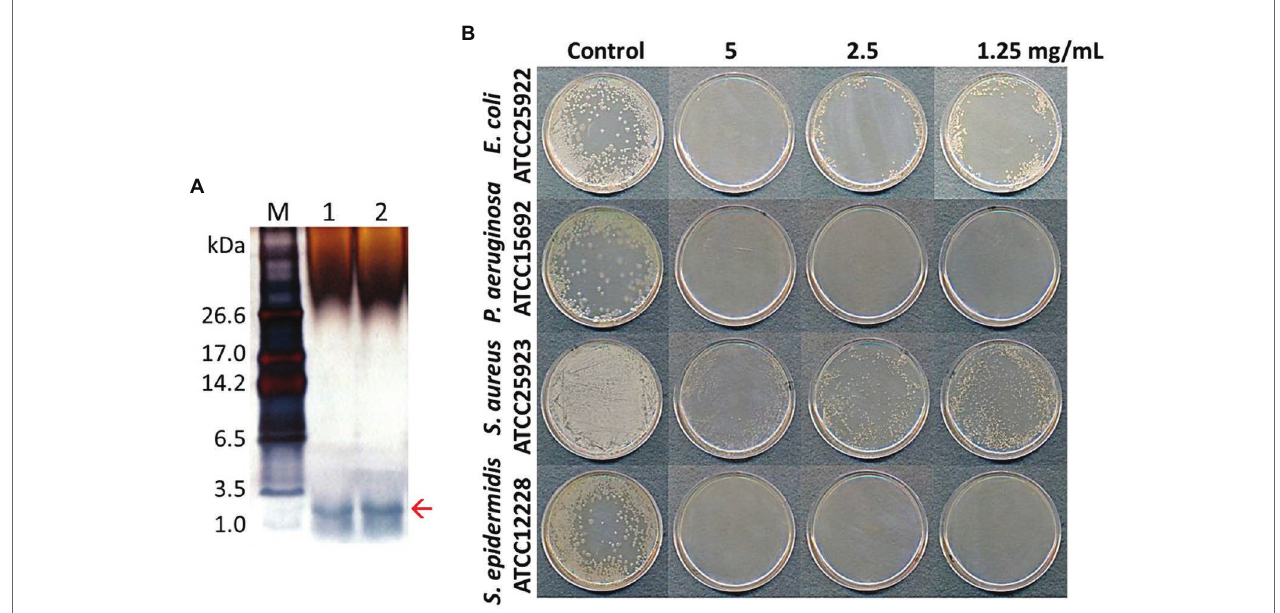
FIGURE 2 | Tricine-SDS-PAGE analysis of total protein extracted from pine needles and evaluation of their antibacterial activity against bacterial strains [lane M; molecular weight size marker, Lanes 1 and 2: total extracted proteins from pine needles (5 and 10 μ g, respectively)] (A) ; Antimicrobial activity of extracted protein fraction against Escherichia coli , Pseudomonas aeruginosa , S. aureus , and Staphylococcus epidermidis (B) . The red arrow indicates the expected PN peptides.